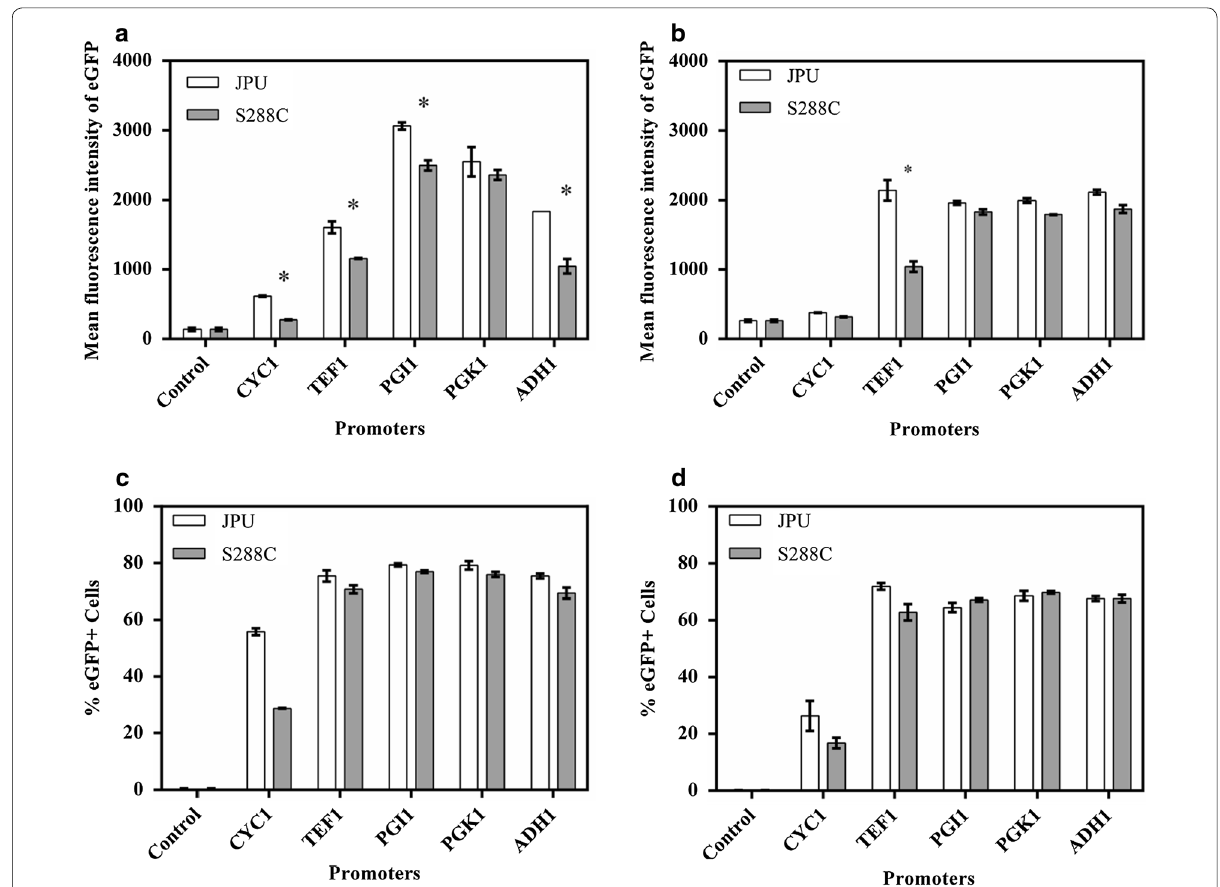
Fig. 1 Comparison of promoter strength in different S. cerevisiae hosts. Promoters from industrial strain JPU ( white bars ) and laboratory strain S288C ( gray bars ) driving the expression of eGFP in JPU ( a ) and CEN.PK2 ( b ) were analyzed by flow cytometry. Only EGFP positive JPU ( c ) and CEN.PK2 ( d ) cells were analyzed for intensity of intracellular fluorescence of EGFP in both cell strains ( c , d ). The asterisk symbol indicates promoters with signifi- cant difference (Two-way ANOVA, p 0.05) in mean fluorescence. The error bars represent the standard error of biological ≤